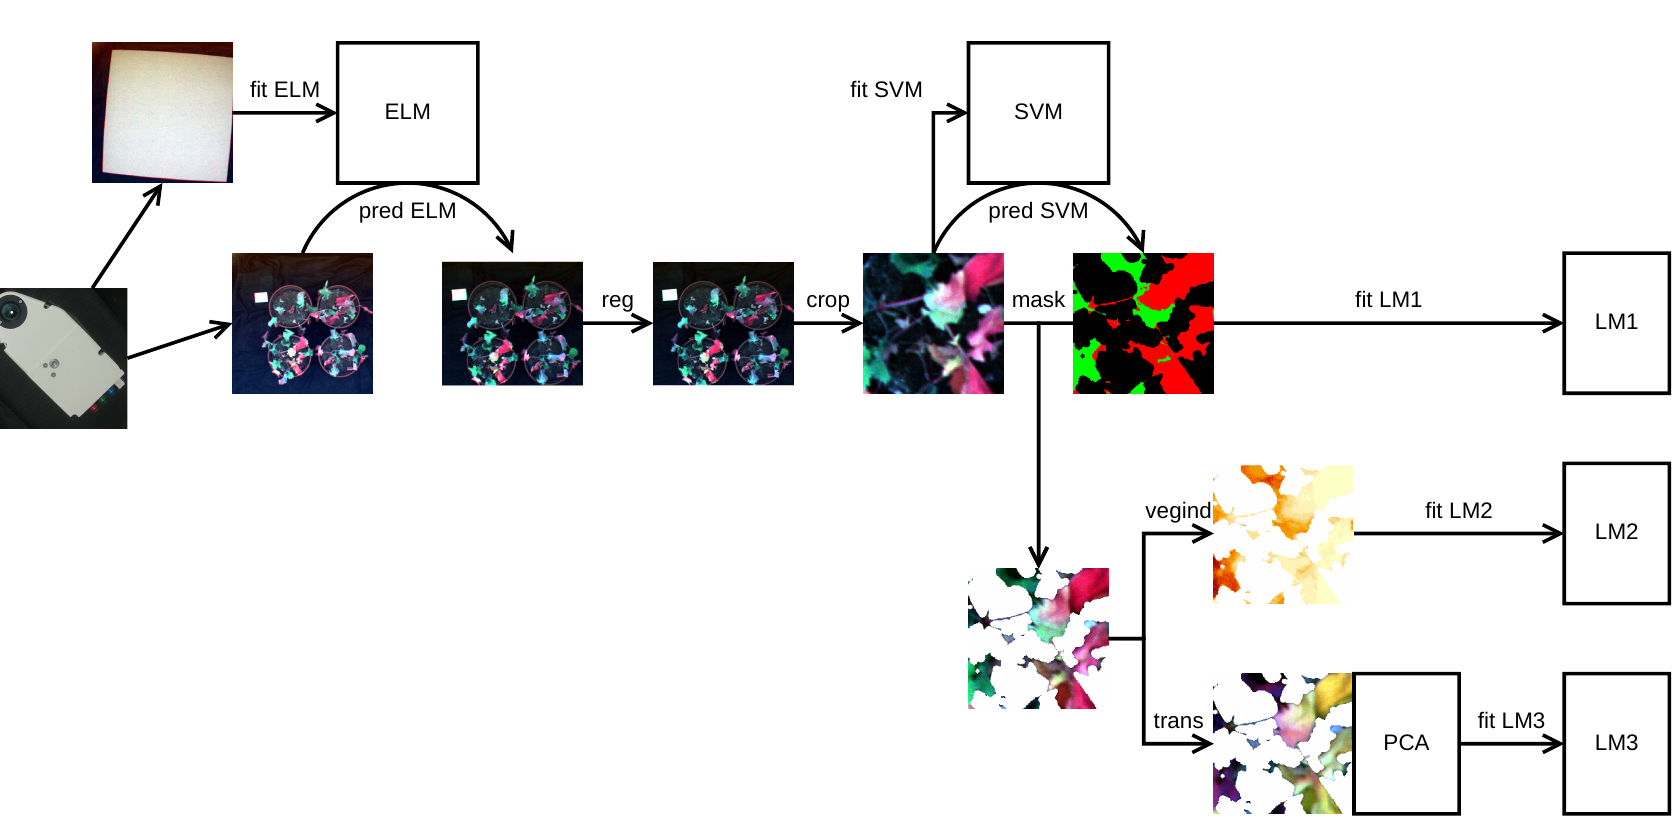
Figure 3. Pre-processing and processing workflow of the hyperspectral images. fit ELM = fitting of an empirical line model, pred ELM = application of the empirical line model to the spectra, reg = band registration, crop = cropping of the images to the regions of interest, fit SVM = fitting of a Support Vector Machine model, pred SVM = pixel classification using the Support Vector Machine model, mask = background masking, fit LM1 = linear modelling of dry-leaf pixel proportions, vegind = deriving of vegetation indexes, fit LM2 = linear modelling of the vegetation index values, trans = spectra pre-processing, fit LM3 = linear modelling of the principal component scores of the pre-processed